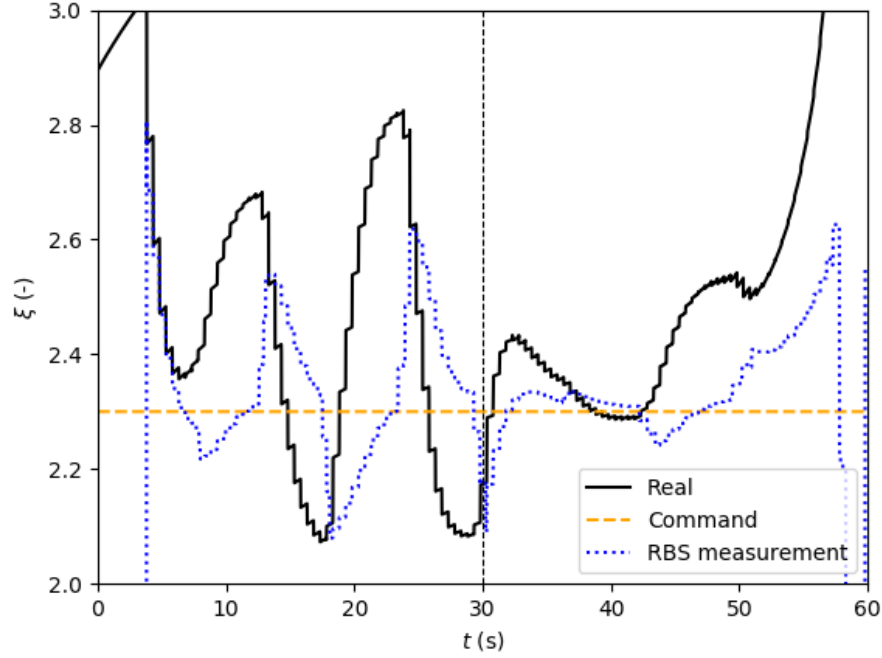
Figure 38. Mixture ratio profile, feedback with downgraded regulation law, case 2, ds = 3